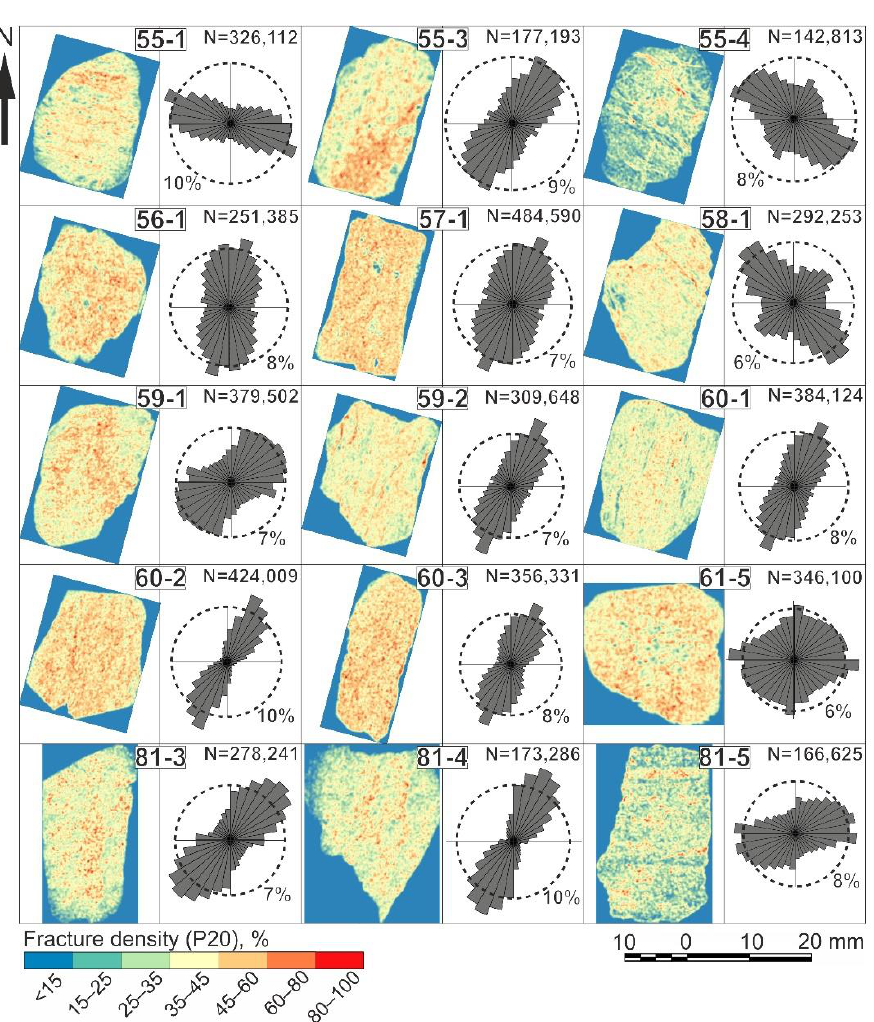
Figure 8. Graphs of the distribution of L/S ( A ) and N/L ( B ) versus permeability. Fracture density maps (P20) [100] of the identified microfractures were built to as- sess the most permeable zones in the thin section. These maps show the areal distribution of microfractures (Figure 9).